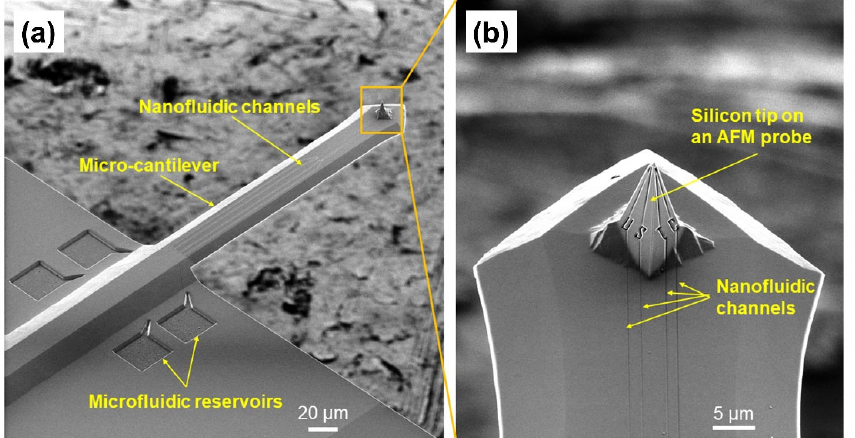
Figure 7. ( a ) Nanofluidic channels directly produced on a suspended micro-cantilever and a Si tip on top of an atomic force microscopic probe. ( b ) Zoomed-in view of the Si nanofluidic channels on both the micro-cantilever and the Si tip.